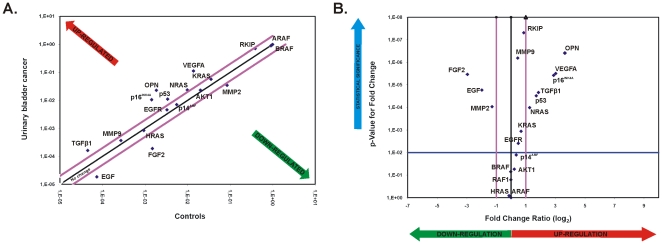
The Scatter Plot graphs the expression level (2∧-ΔCt) of each gene in BC samples versus the control samples.The black line indicates fold changes of 1. The pink lines indicate the threshold in gene expression fold-change (2-fold difference). qPCR revealed up- and down-regulated genes in urinary bladder cancer. Total RNA from the normal adjacent tissue and urinary bladder cancer were characterized in technical triplicates, and the relative expression levels for each gene in the two tissue types were plotted against each other in the Scatter Plot. VEGFA, OPN, p14INK4A, p6CDKN2A, NRAS and TGFβ1 were up-regulated, while FGF2 and EGF were down-regulated by at least two-fold (outside the purple lines). The genes KRAS, MMP2, AKT1, p53, EGFR, MMP9 and HRAS exhibited equal expression between bladder cancer and normal tissue (A). The Volcano Plot graphs the log2 of the fold change in expression of each gene between the BC samples versus its p-value from the t-test. The black line indicates fold changes of 1. The pink lines indicate the threshold in gene expression fold-change (2-fold difference). The blue line indicates the threshold for the p-value of the t-test (0.01) (B).